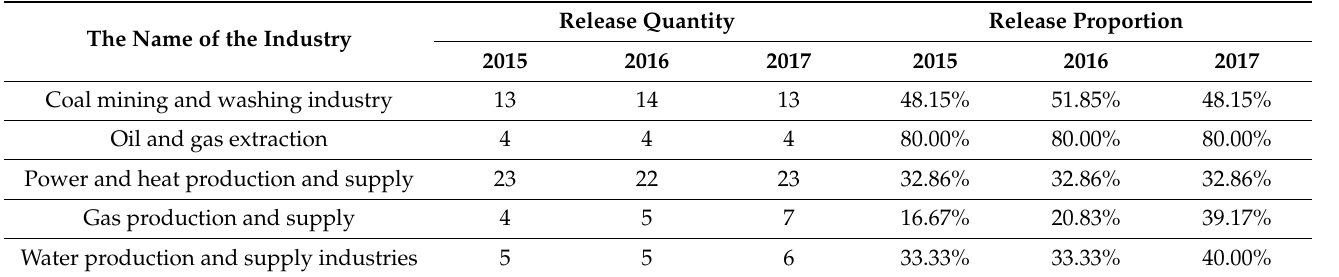
Figure 4. Distribution of energy saving and environmental protection information disclosure. Table 3. Occupational safety and health related information industry distribution (in last three